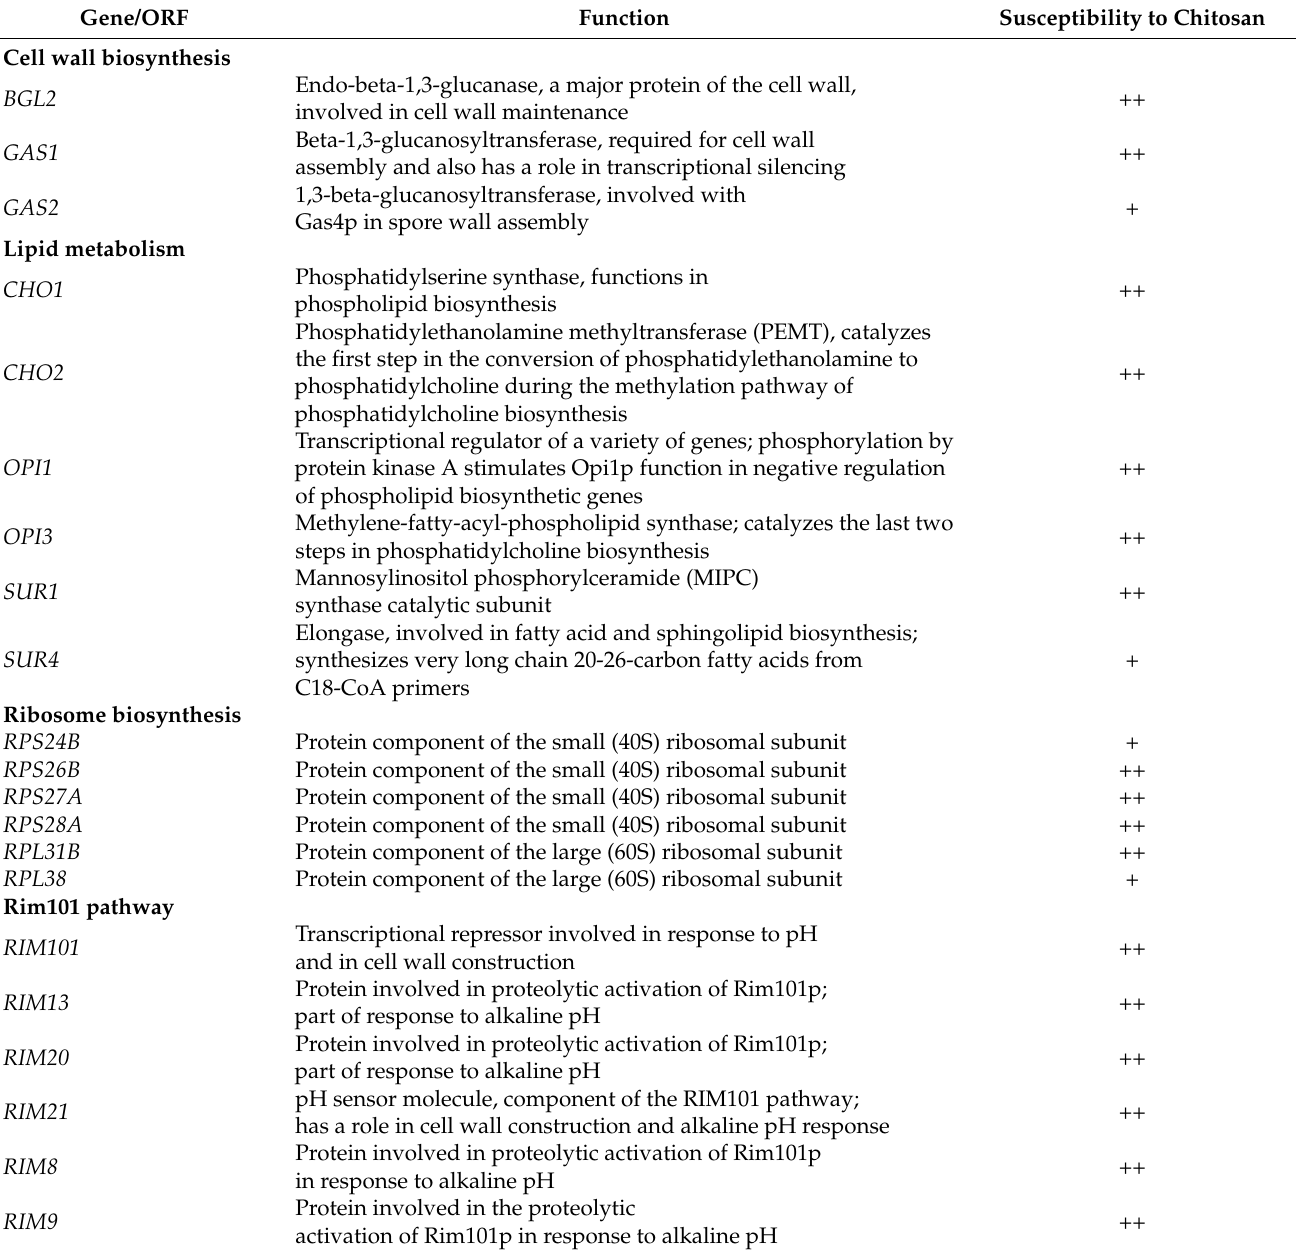
Table 2. Genes whose deletion increases the susceptibility to chitosan No Brett Inside ® (at pH